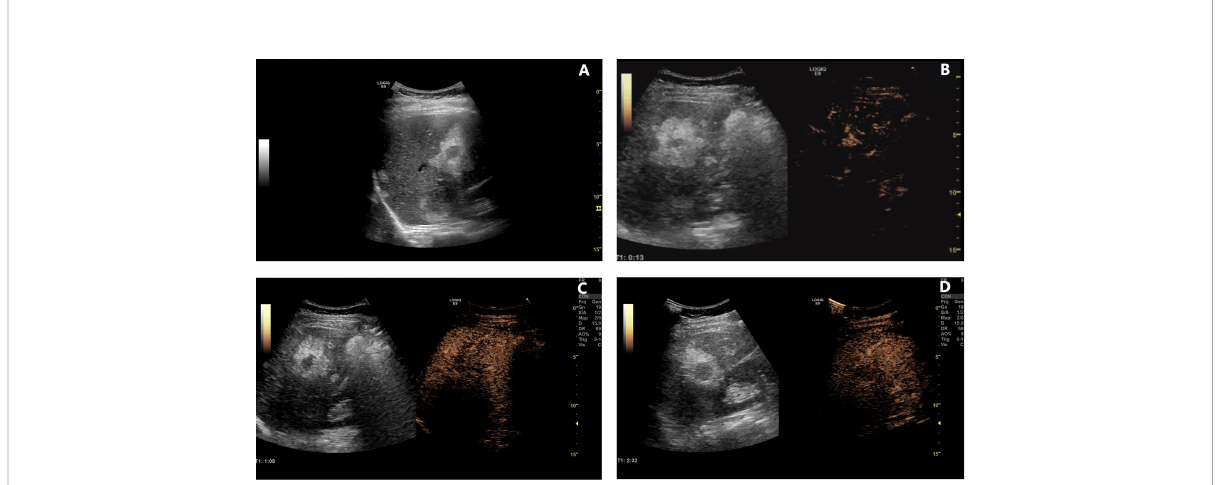
FIGURE 3 Contrast-enhanced ultrasonography of lesions in the liver. (A) B-mode ultrasound examination revealed several lesions with an inner hypoechoic area and outer hyperechoic area. (B – D) Contrast-enhanced ultrasonographic scans [ (B) , 13 s in the arterial phase; (C) , 68 s in the portal venous phase; (D) , 152 s in the delayed phase] showed rapid enhancement in the arterial phase, early washout in the portal venous phase, and hypo-enhancement in the delayed phase in the inner hypoechoic area. However, the peripheral area was continuously iso-enhancing or hypo-enhancing.